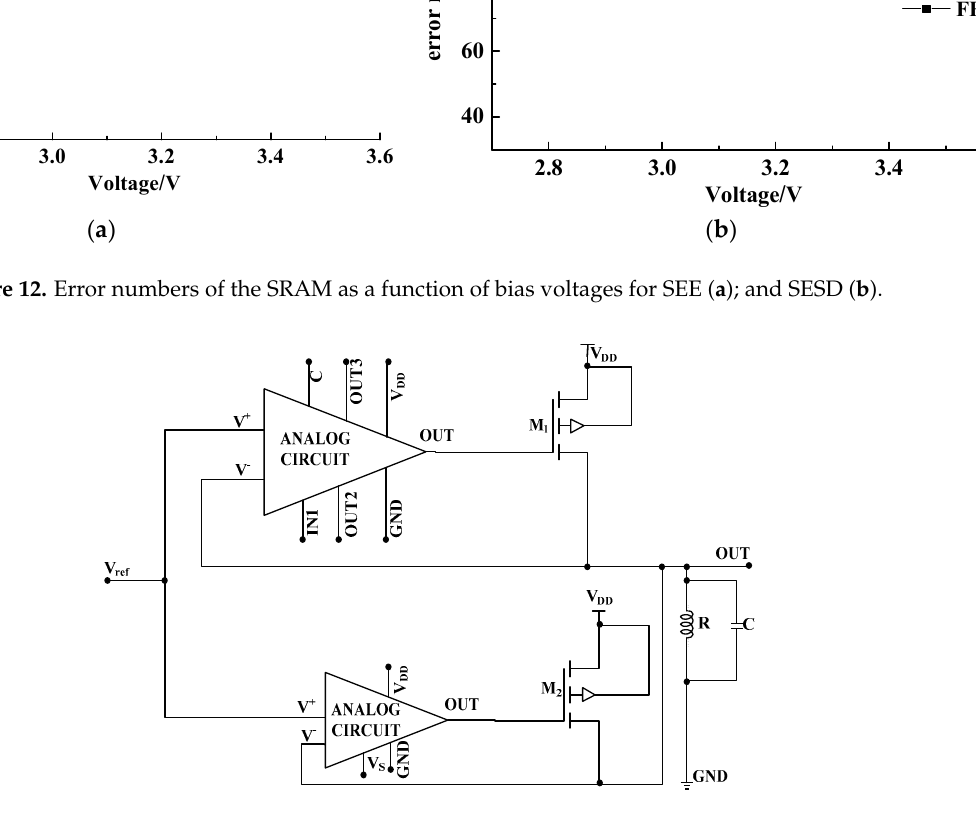
Figure 13. The partial detail circuits of the power supply network for the HM62V8100i